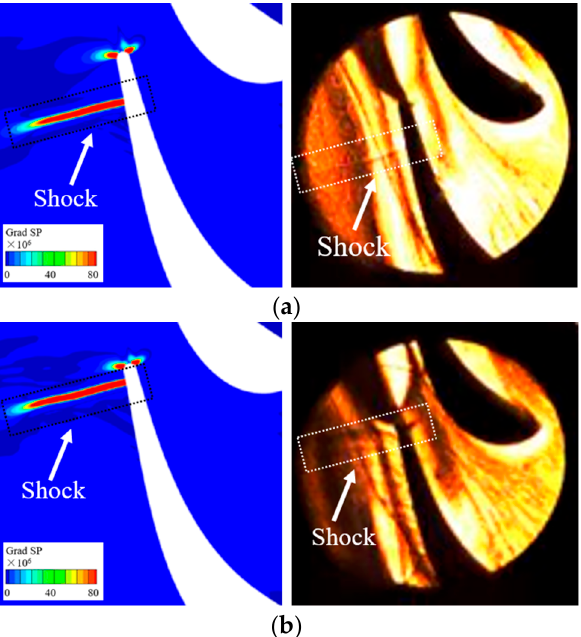
Figure 16. Shocks of the base model for the CFD and experiment at different expansion ratios: ( a ) shock at a 2.0 expansion ratio; ( b ) shock at a 2.2 expansion ratio.